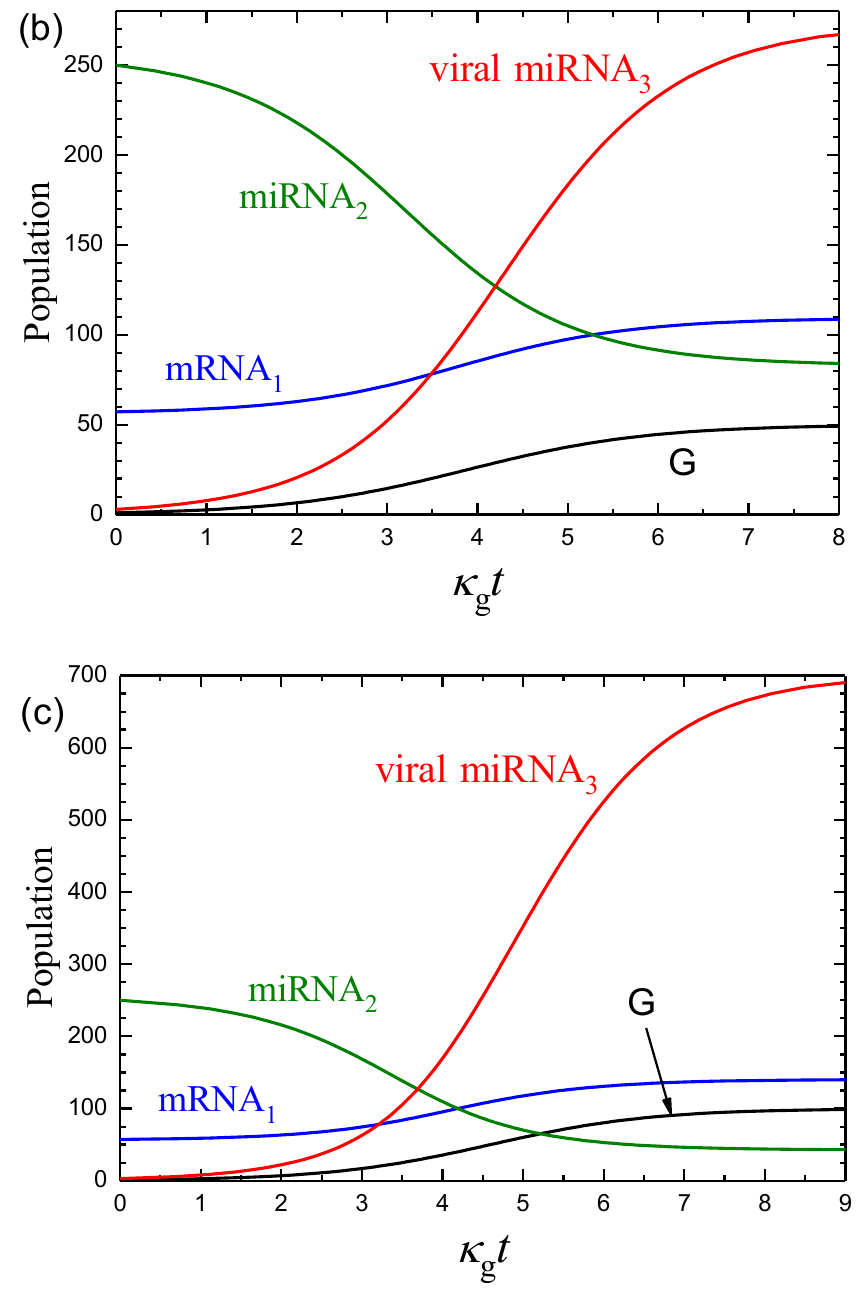
Figure 2. mRNA 1 , miRNA 2 , miRNA 3 , and G and populations as a function of κ g t according to Equations (19) and (20) with n g ( 0 ) = 1 for n ∗ = 20 ( a ), 50 ( b ), and 100 ( c ) and the other parameters ( w 1 / k = 200, w 2 / k = 400, κ 12 / k = κ 23 / k = 0.01, and κ 3 / k = 10) as in Figure 1. In this model, the infection of a cell is possible by one virion [ n g ( 0 ) = 1], in agreement with the so-called independent action hypothesis [40]. In the absence of virus ( n g = 0 and n 3 = 0), the mRNA 1 and miRNA 2 population are n 1 = 56 and n 2 = 256 (Figure